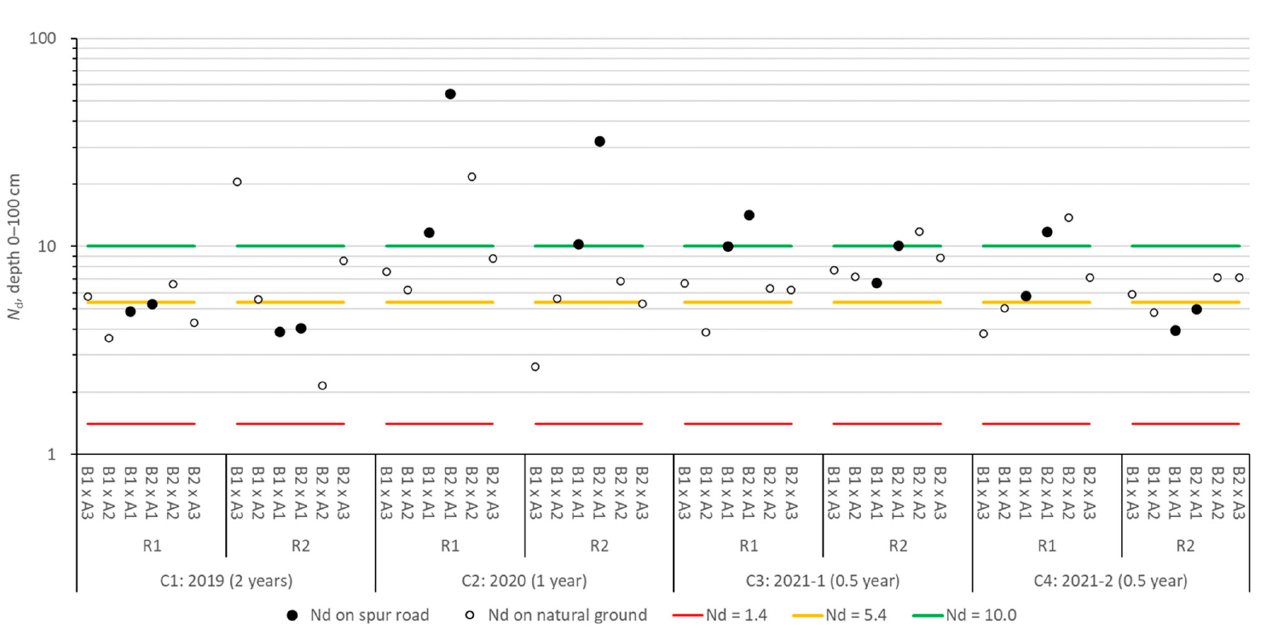
Figure 13. Interaction of Factor B (downhill side or uphill side), Factor C (fiscal year of construction), and Factor D (penetrating depth) of Site 2 on the N d -value. The error bars and different letters have the same meaning as in Figure 9. p < 0.01, n = 6. B1: Downhill side, B2: Uphill side; D1: 0–50 cm, D2: 50–100 cm.